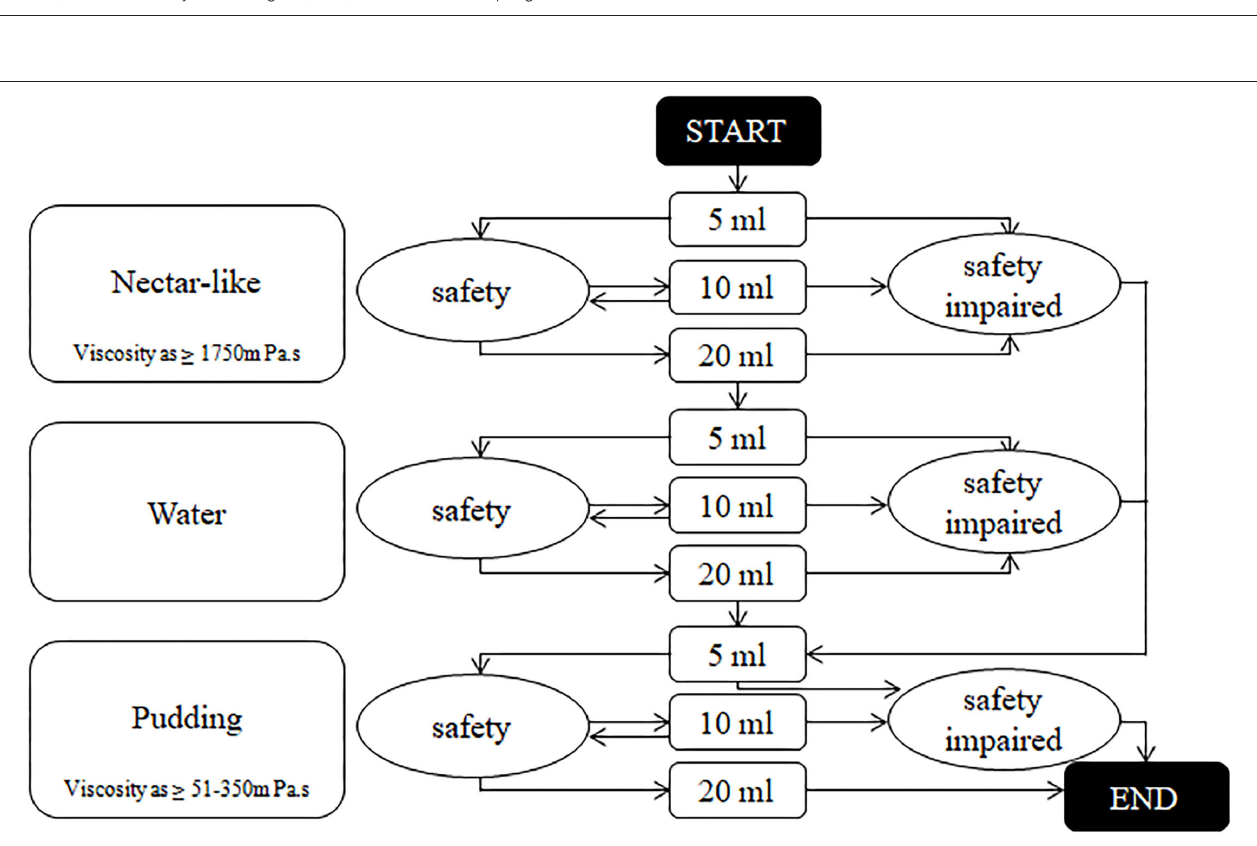
FIGURE 2 | The algorithm of volume-viscosity swallowing test. Output result was the viscosity and sip size of the previous stage before any signs of safety impaired.